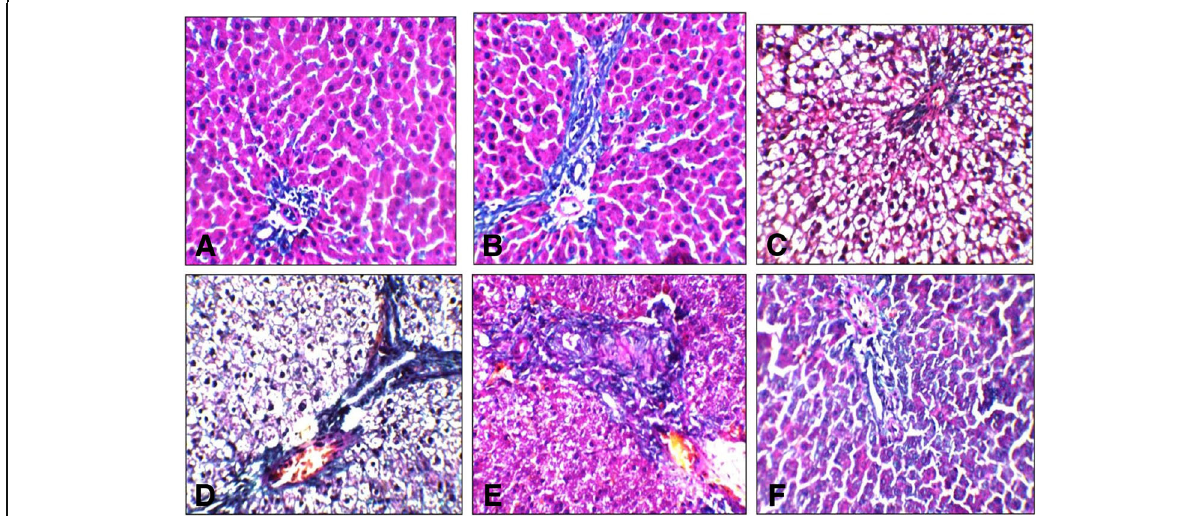
Fig. 3 a A section in the liver of control rats showing normal distribution of collagen fibers and fibrils, normal hepatocytes, normal blood sinusoids, and portal area. b A section in the liver of treated rats with curcumin extract showing normal distribution of collagen fibers. c , d A section in the liver of 500 and 2000 mg/kg COC-treated rat showing degenerated hepatocytes with deposition of collagen fibers around the central vein and in the dilated blood sinusoids. e A section in the liver of 2000 mg/kg COC- and curcumin-treated rat showing branches of the hepatic portal vein, hepatic artery, and bile duct with marked deposition of collagen fibers surrounding them. f A section in the liver of 500 mg/ kg COC- and curcumin-treated rat showing branches of the hepatic portal vein, hepatic artery, and bile duct with mild deposition of collagen fibers surrounding them (Masson ’ s trichrome ×